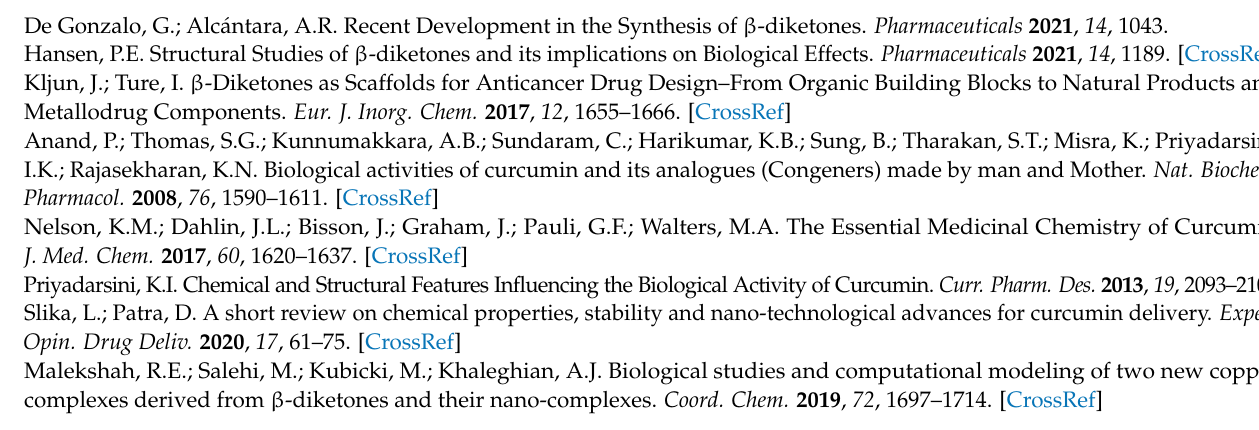
Figure 18. Dependence of deuterium isotope effects on chemical shifts in β -diketones as a function of the mole fraction. Taken from Ref. [99] with permission from John Wiley and sons.